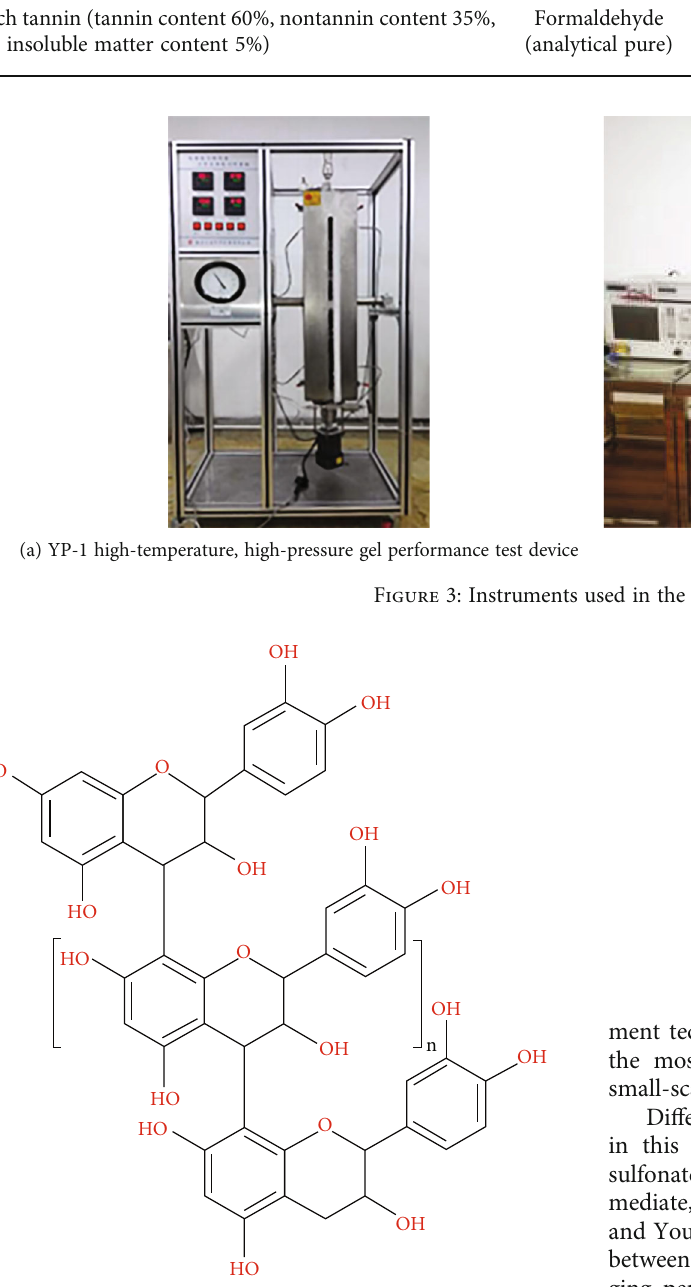
Figure 4: Polyprocyanidin [42].